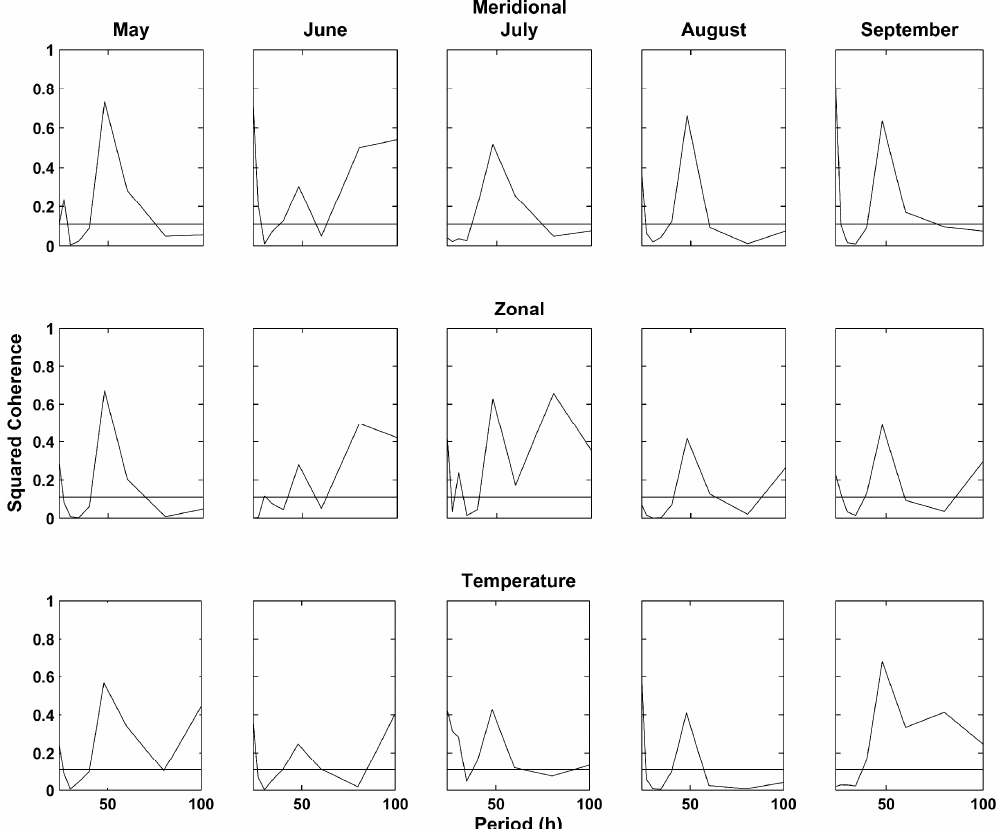
Fig. 8. Squared-coherence between meridional (a) , zonal (b) winds and temperature (c) of IMD and ERA datasets for each month. The period range is from 24h to 100h. 95% confidence levels have been marked with horizontal solid lines.